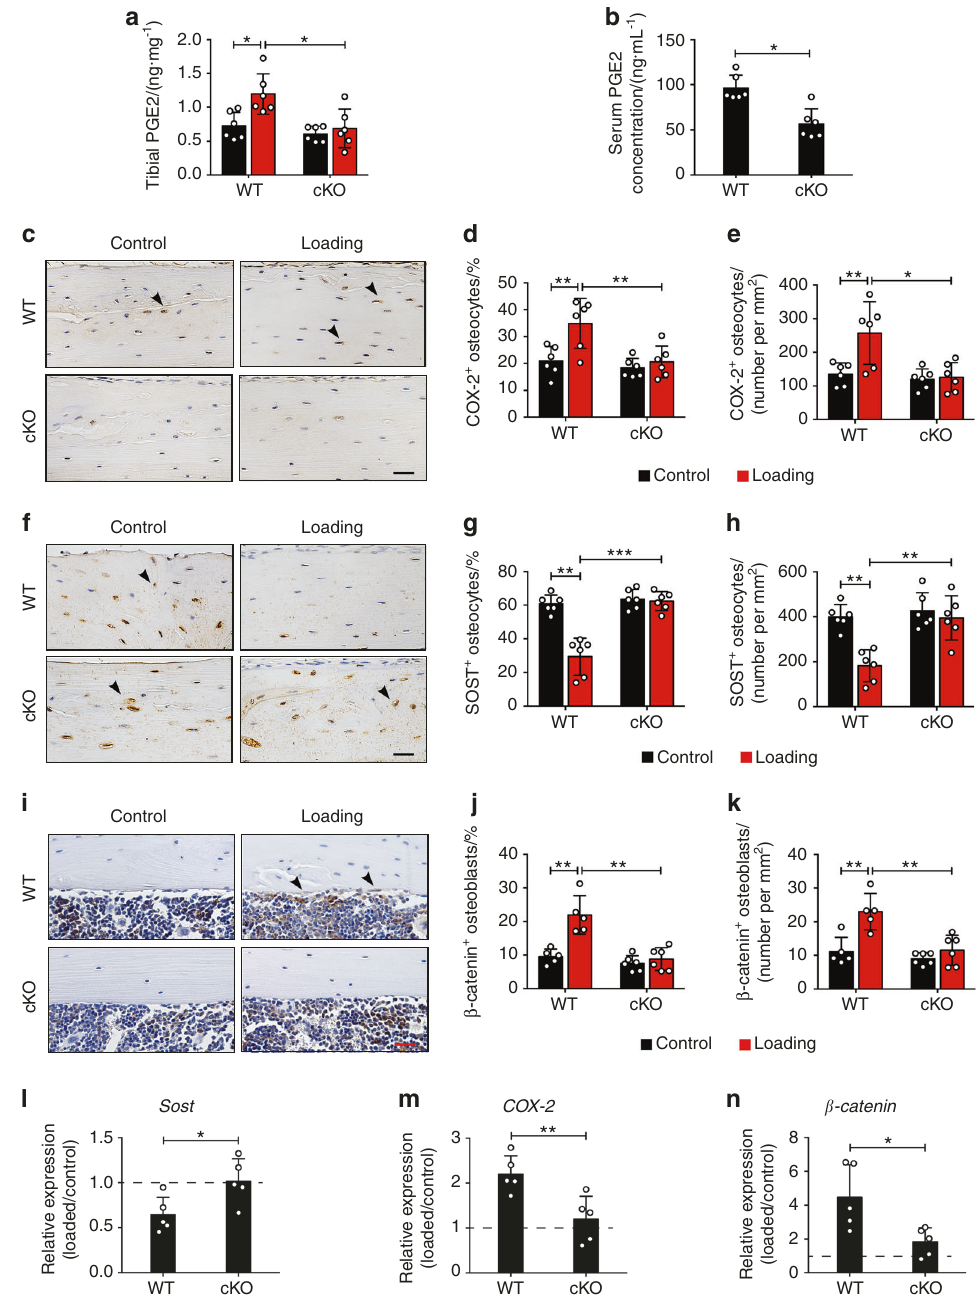
Fig. 7 Loading-induced increased PGE2 secretion with a decrease in SOST expression was inhibited in cKO mice. a , b ELISA analysis of PGE2 level in bone marrow- fl ushed tibial diaphysis ( a ) and serum ( b ) after 5-day mechanical loading. n = 6 per group. c Representative COX-2 immunohistostaining (black arrows) and d , e quanti fi cation of COX-2-positive osteocytes in diaphyseal 37% cortical bone. Scale bar, 30 μ m. n = 6 per group. f Representative SOST immunohistostaining (black arrows) and g , h quanti fi cation of SOST-positive osteocytes in diaphyseal 37% cortical bone. Scale bar, 30 μ m. n = 6 per group. i Representative β -catenin immunohistostaining (black arrows) and j , k quanti fi cation of β -catenin-positive osteoblasts on endosteal surface of diaphyseal 37% cortical bone. Scale bar, 30 μ m. n = 5 – 6 per group. l – n Relative gene expression of Sost ( l ), COX-2 ( m ), and β -catenin ( n ) was determined by RT-qPCR in the tibial diaphysis of WT and cKO mice. n = 5 per group. Mean ± SD. * P < 0.05; ** P < 0.01; *** P < 0.001. Paired t test was done for loaded and contralateral tibias and unpaired t test was done for loaded or control tibias between WT and cKO α 5 β 1 and Cx43 in the response to mechanical loading in bone loading promotes endosteal osteoblast activity, which is probably tissue. Interestingly, mechanical loading stimulated osteoclast regulated by mechanosensitive integrin α 5. activity on the antero-medial endosteal surface in both WT and α 5 On the contrary, tibial loading cause an increase in periosteal cKO groups. The data is consistent with the study by Birkhold bone formation and total tissue area in both WT and α 5 cKO mice. et al., showing that bone resorption increased with loading at We exclude the regional structural differences because of similar medial regions in both metaphysis and diaphysis. 37 Thus, tibial osteocyte dendrites near periosteal surface in WT and cKO mice.